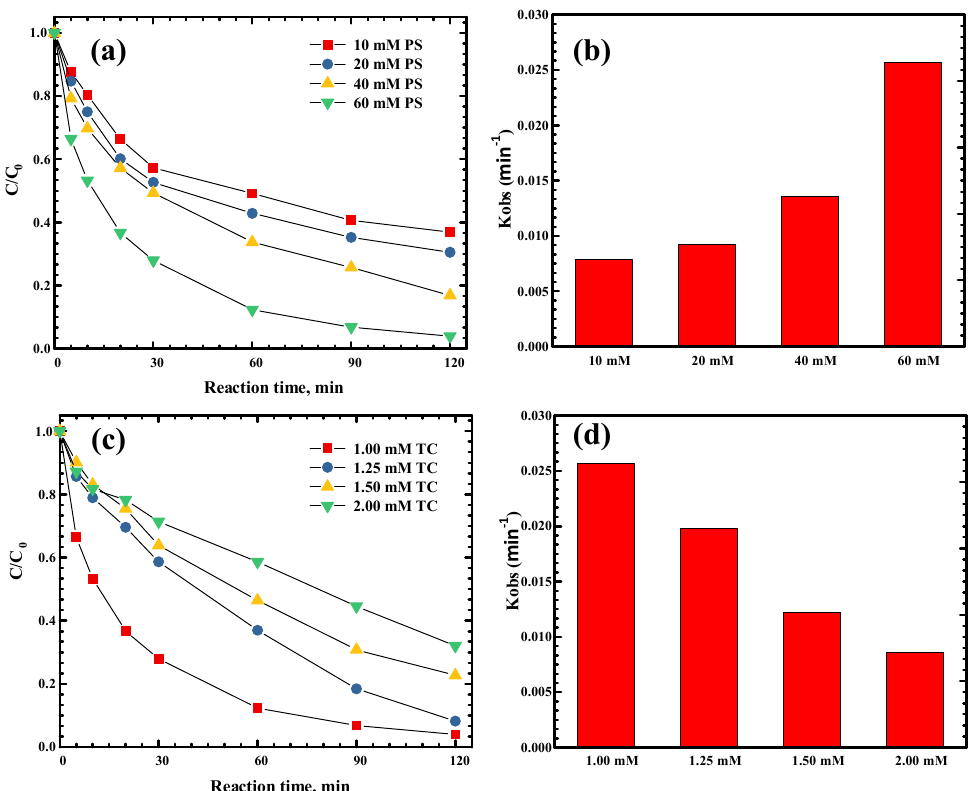
Figure 6. Effects of persulfate ( a , b ) and initial TC ( c , d ) concentration for catalytic reduction of